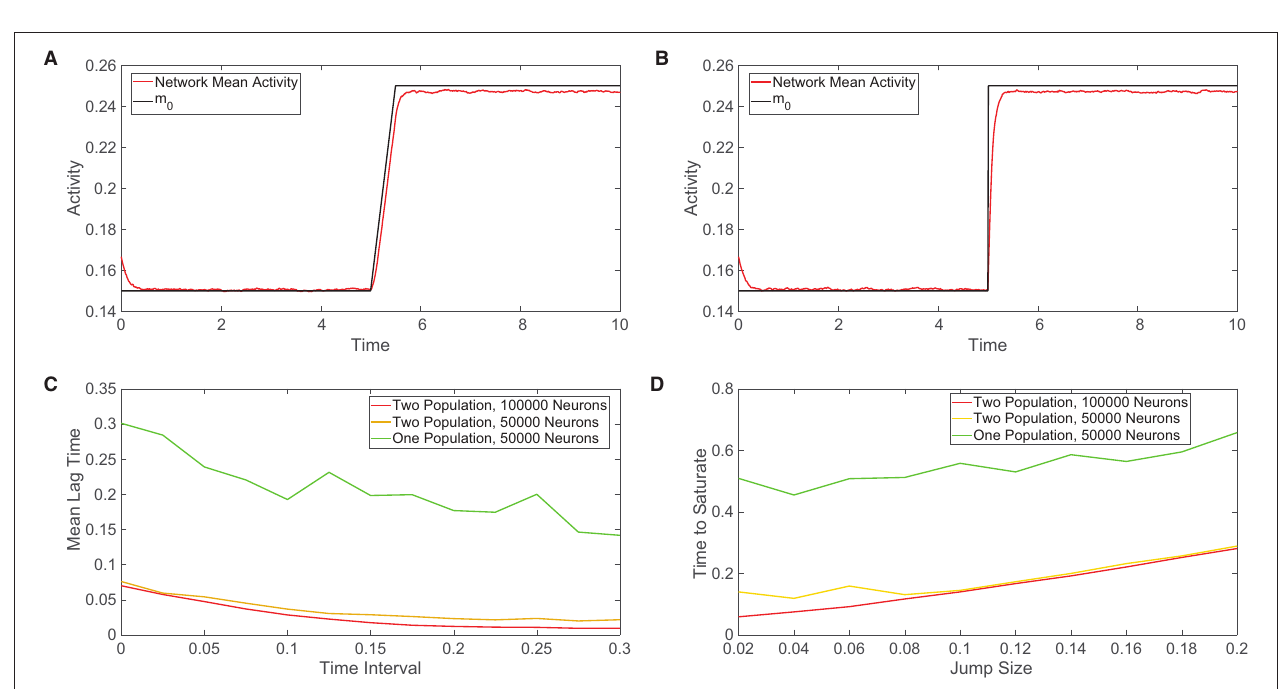
FIGURE 5 | Comparison of the tracking of network inputs. (A) Mean activity in the one-population model plotted over time (red) for an external input that evolves continuously in time. The external input strength parameter m 0 varies over time and is plotted for comparison (black), while all other parameters are fixed. Here the external input is either constant or linearly increases in time. (B) Analogous plot as in (A) , except now the external input changes discontinuously at t discontinuity and remains constant otherwise. The same range of m 0 values is used in each plot. (C) Across a family of linearly-ramped inputs of the form in panel (A) , the time interval over which the external input transitions from its fixed minimal value to its fixed maximal value is varied. For each such time interval, the mean lag time between the network response and the external input is plotted. The mean lag time plotted for each input is the time difference between the mean activity and the external input averaged from when the external input first begins to change in time until the network mean activity saturates (reaches the value of the long-time, time-averaged mean activity following input saturation). (D) Across a family of discontinuous inputs of the form in (B) , the maximal value of the external input is varied. For each resultant input jump size, the time elapsed from the input jump until the network mean activity saturates is plotted. In (C,D) , the fast-tracking properties are plotted in red for the two-population network with 100,000 neurons, in orange for the two-population network with 50,000 neurons, and in green for the one-population network with 50000 neurons. Parameters in the one-population network utilized are J E Parameters in the two-population network utilized are J